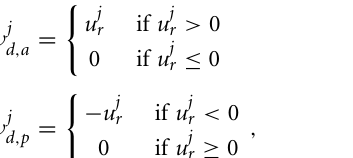
FIGURE 8 | Implementation of the shoulder extension/flexion controller including an anti-windup observer with R( q ) = (1 − q ) R( q ), a trajectory generator and an adjustable initial stimulation